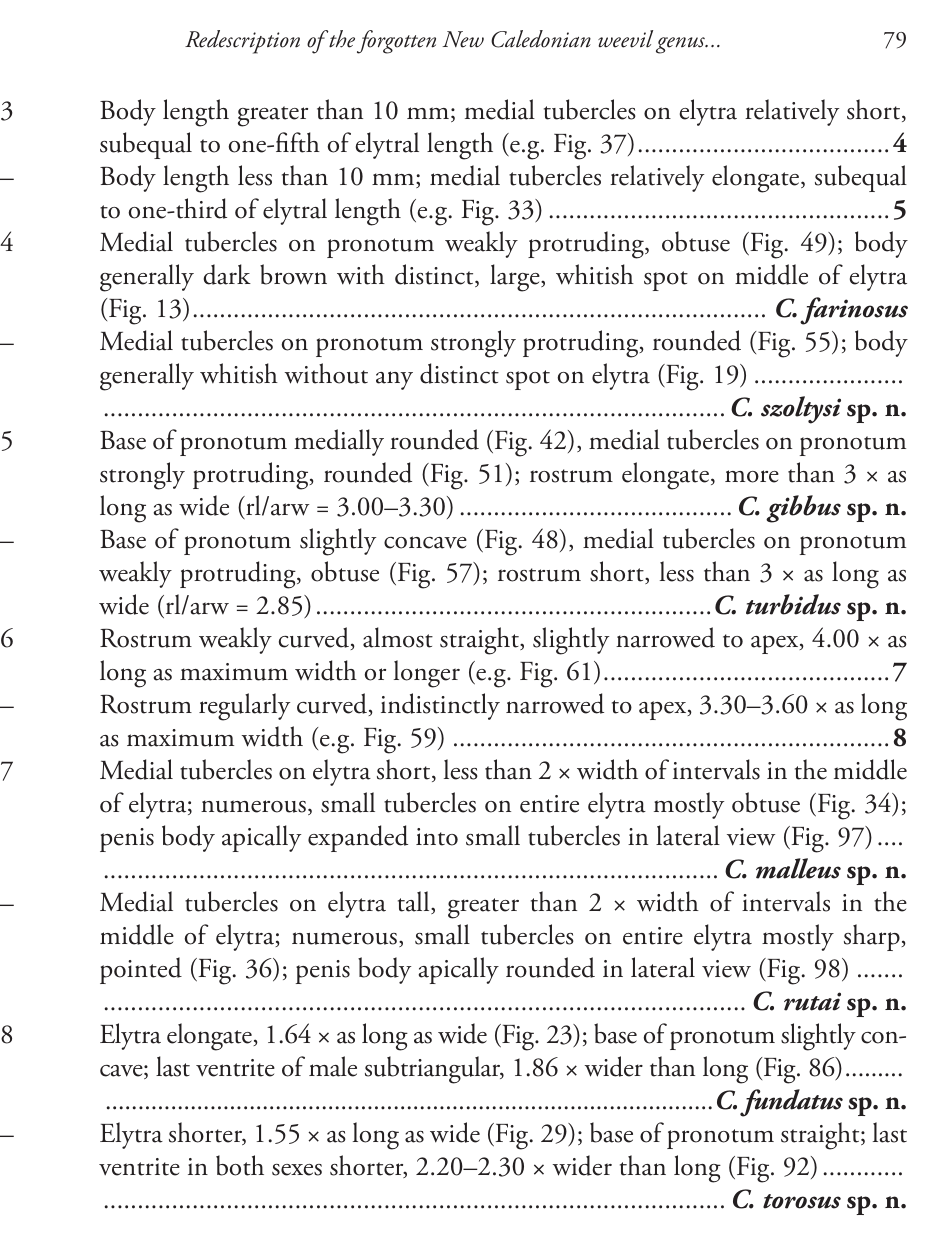
Body length greater than 10 mm; medial tubercles on elytra relatively short, subequal to one-fifth of elytral length (e.g. Fig. 37) ..................................... 4 – Body length less than 10 mm; medial tubercles relatively elongate, subequal to one-third of elytral length (e.g. Fig. 33) .................................................. 5 4 Medial tubercles on pronotum weakly protruding, obtuse (Fig. 49); body generally dark brown with distinct, large, whitish spot on middle of elytra (Fig. 13) .................................................................................... C. farinosus – Medial tubercles on pronotum strongly protruding, rounded (Fig. 55); body generally whitish without any distinct spot on elytra (Fig. 19) ...................... 5 Base of pronotum medially rounded (Fig. 42), medial tubercles on pronotum strongly protruding, rounded (Fig. 51); rostrum elongate, more than 3 × as long as wide (rl/arw = 3.00–3.30) ........................................ C. gibbus sp. n. – Base of pronotum slightly concave (Fig. 48), medial tubercles on pronotum weakly protruding, obtuse (Fig. 57); rostrum short, less than 3 × as long as wide (rl/arw = 2.85) .......................................................... C. turbidus sp. n. 6 Rostrum weakly curved, almost straight, slightly narrowed to apex, 4.00 × as long as maximum width or longer (e.g. Fig. 61) .......................................... 7 – Rostrum regularly curved, indistinctly narrowed to apex, 3.30–3.60 × as long as maximum width (e.g. Fig. 59) ................................................................ 8 7 Medial tubercles on elytra short, less than 2 × width of intervals in the middle of elytra; numerous, small tubercles on entire elytra mostly obtuse (Fig. 34); penis body apically expanded into small tubercles in lateral view (Fig. 97) .... – Medial tubercles on elytra tall, greater than 2 × width of intervals in the middle of elytra; numerous, small tubercles on entire elytra mostly sharp, pointed (Fig. 36); penis body apically rounded in lateral view (Fig. 98) ....... 8 Elytra elongate, 1.64 × as long as wide (Fig. 23); base of pronotum slightly con- cave; last ventrite of male subtriangular, 1.86 × wider than long (Fig. 86) ......... – Elytra shorter, 1.55 × as long as wide (Fig. 29); base of pronotum straight; last ventrite in both sexes shorter, 2.20–2.30 × wider than long (Fig. 92)